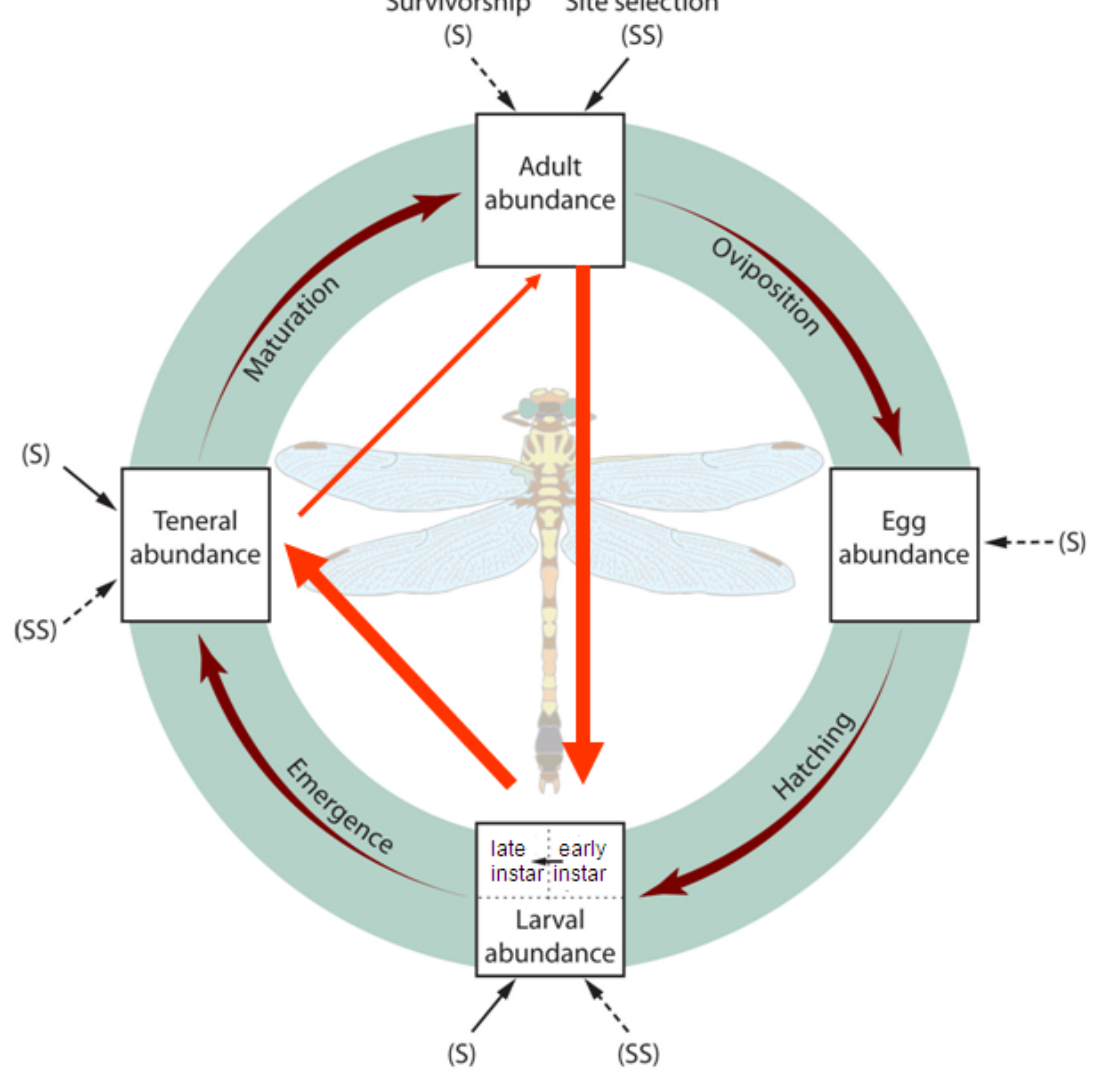
Figure 1. Diagram of the life history of temperate dragonflies. Dotted lines illustrate the relatively weak effects of survivorship (S) and site selection (SS) on dragonfly abundances at the designated stages. Arrows in the center indicate the correlations tested in this research, assuming that exuviae (cast-off exoskeletons) abundance indicates relative abundance of teneral